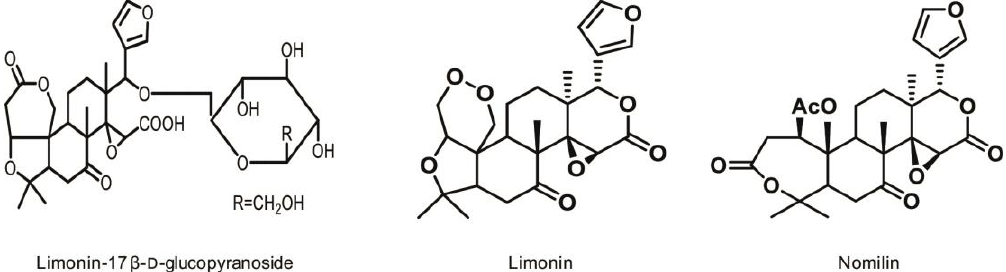
Figure 1. The most abundant limonoid glucoside and aglycones.